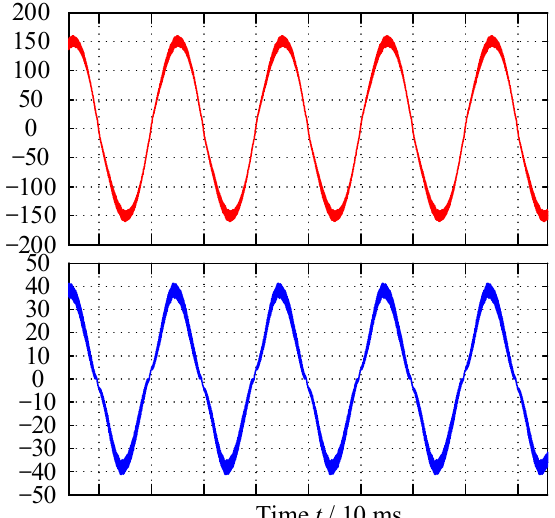
Figure 8. Simulation results of the proposed buck–boost inverter working as boost-type inverter.